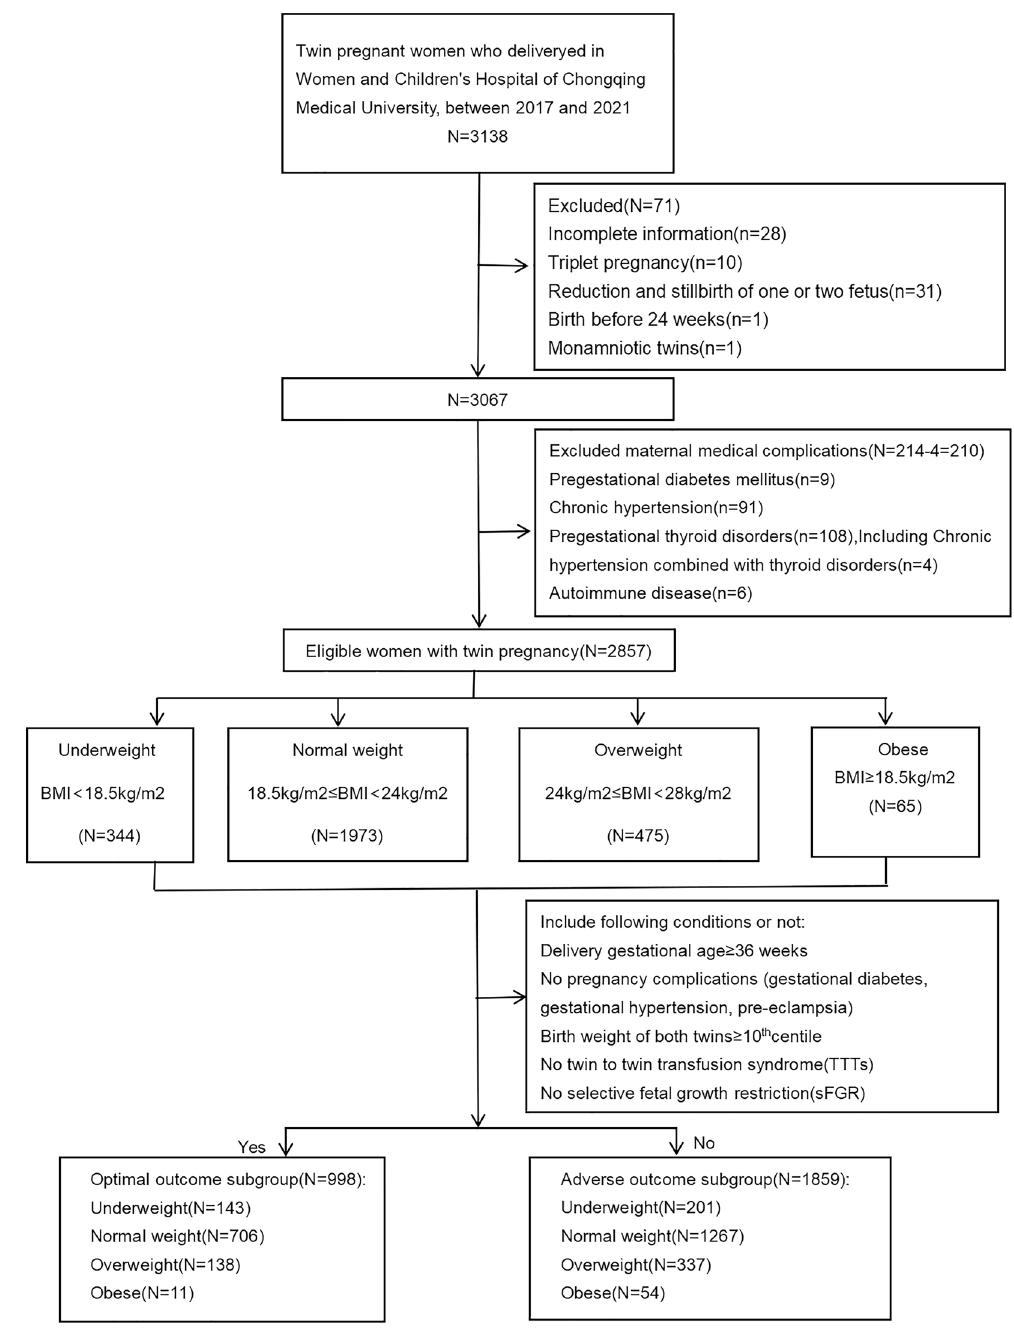
Figure 1. Flowchart of the enrolled